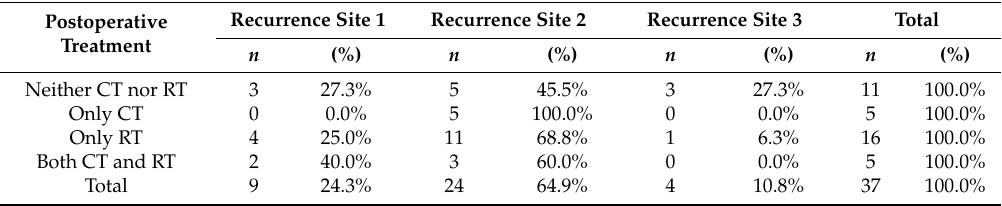
Table 4. Postoperative treatments and the recurrent site.